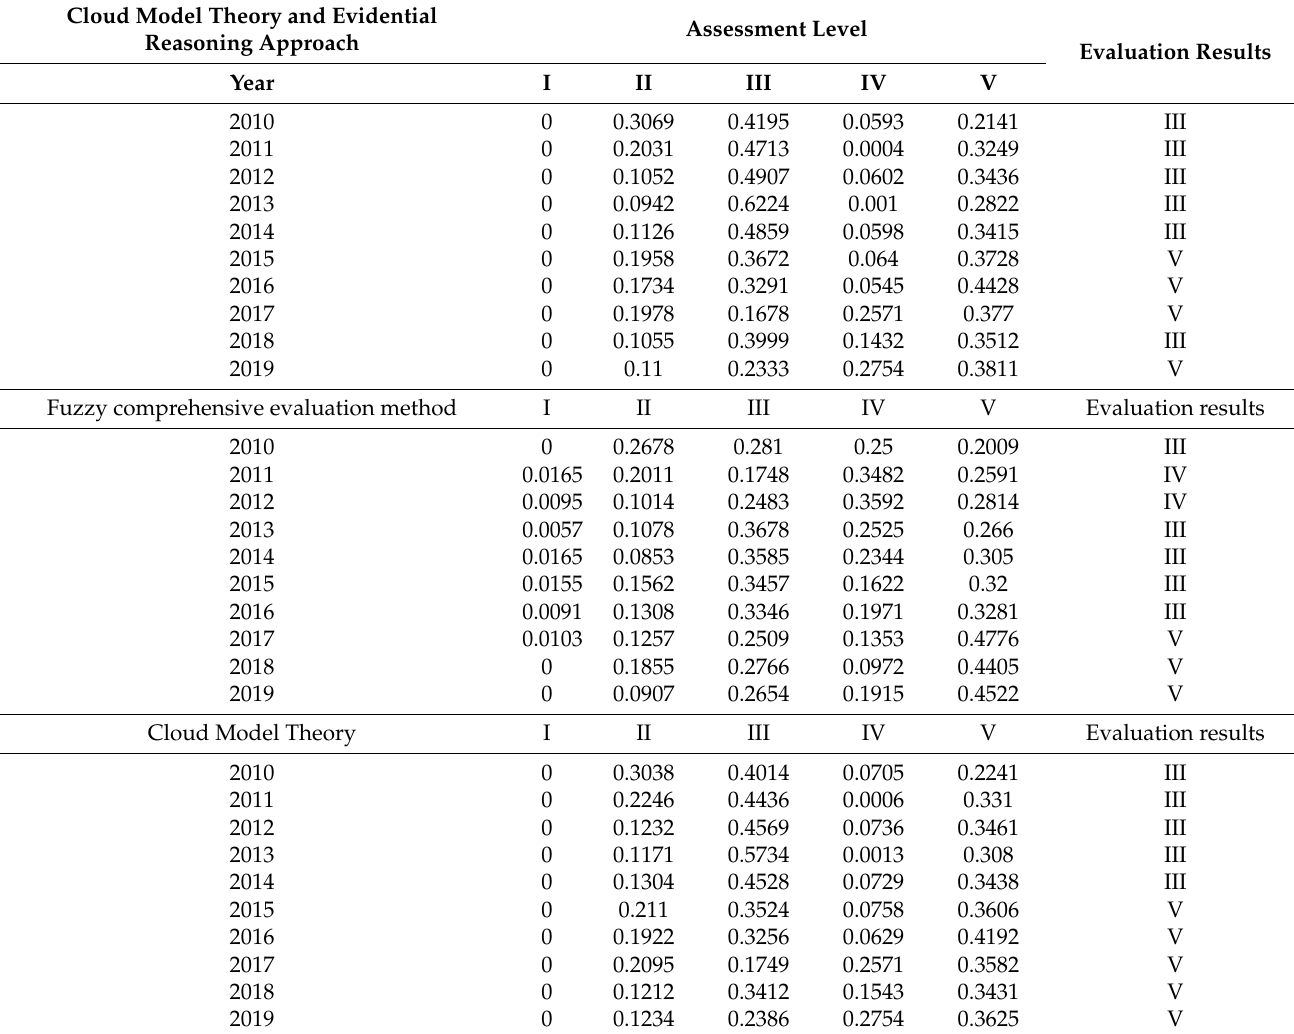
Table 6. Comparison of evaluation results and